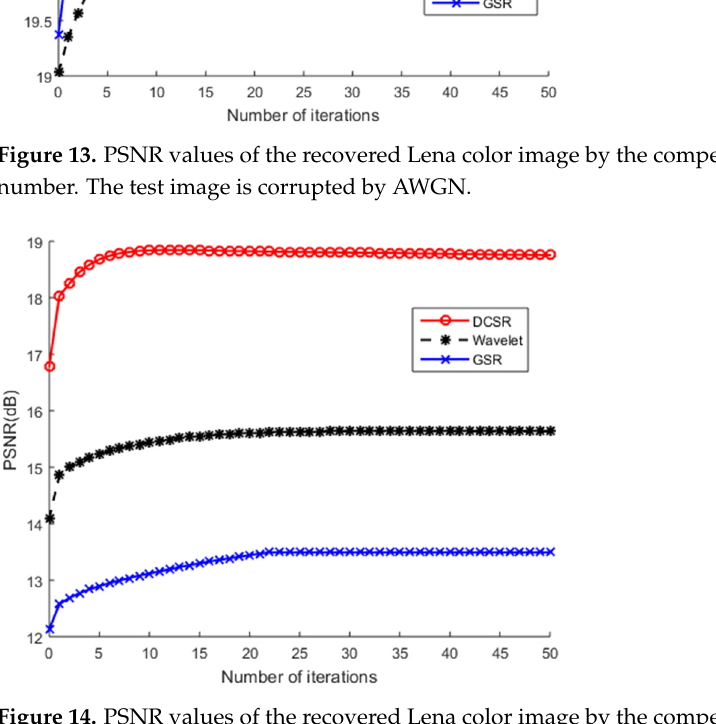
Figure 14. PSNR values of the recovered Lena color image by the competing methods vs. iteration number. The test image is corrupted by salt and pepper noise.